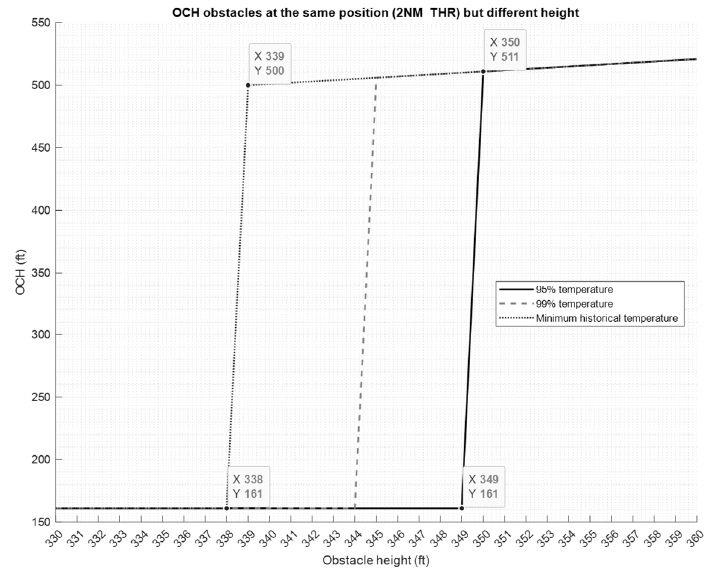
Figure 12. OCH with obstacles in the same position but at different heights. Similarly, the event of considering the same obstacle at different distances from the threshold was analyzed, obtaining the OCH for different design temperatures. (see Figure 13).